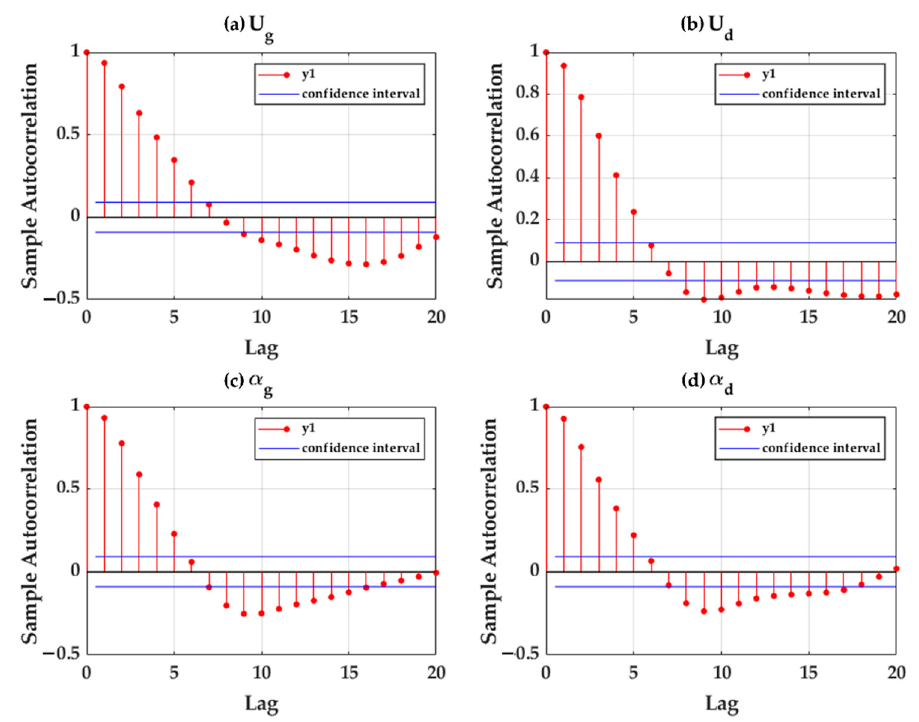
Figure 11. Autocorrelation function curves (ACF) of first order differenced time-series ( a ) U g ( b ) α g ( c ) U d ( d ) α d .